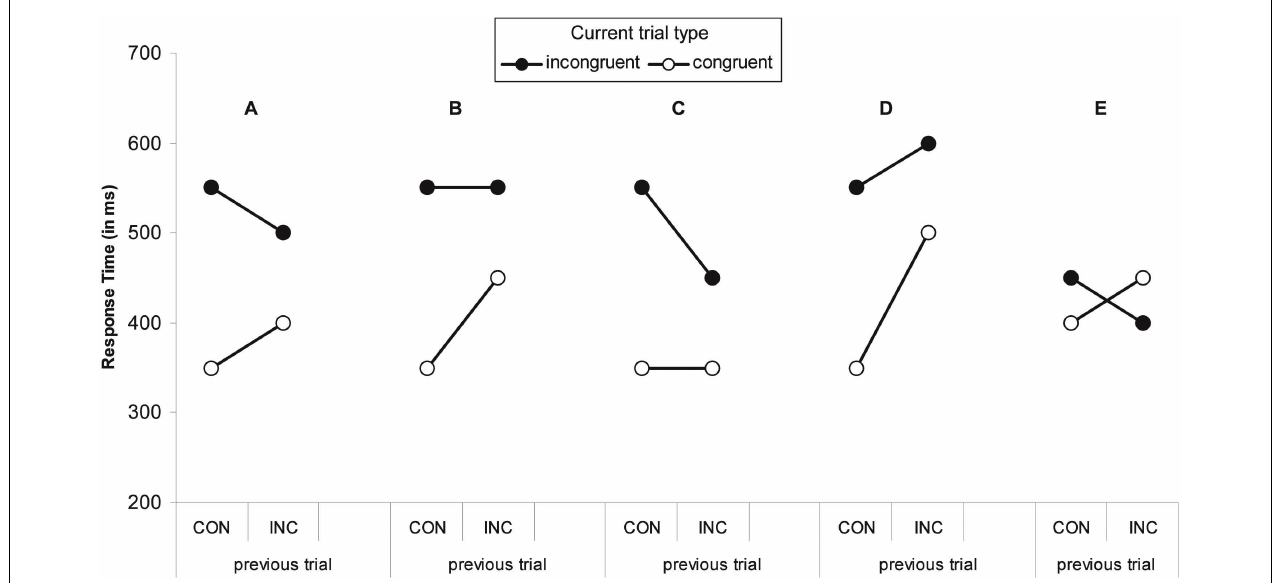
The same interaction effect size can be obtained with patterns that have no sequence effects for incongruent (B) or congruent (C) trials. Pattern (D) indicates worse control for incongruent trials after an incongruent trial. Patern (E) shows a congruency reversal. Pattern (C) can be obtained in Stroop tasks, whereas pattern (E) is found in Simon